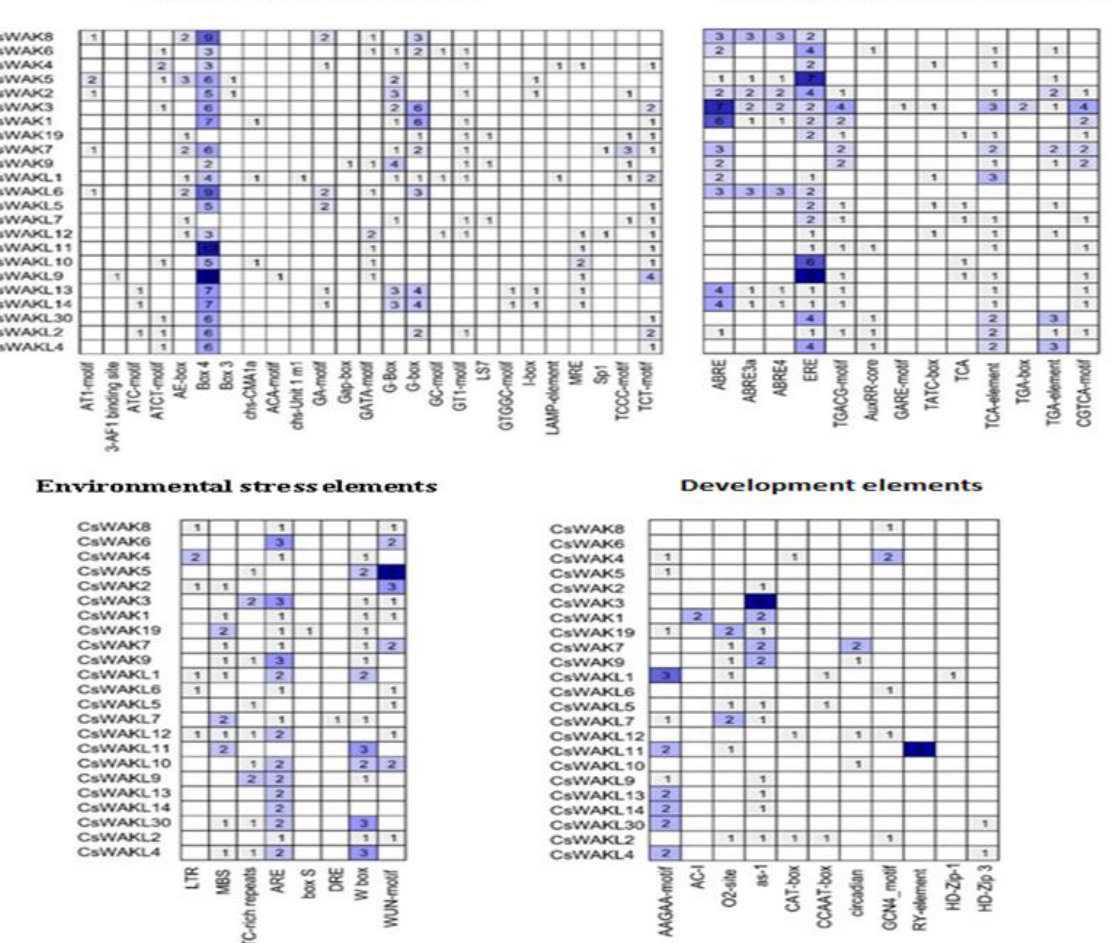
Figure 7. Cis-acting elements in promoter regions of CsWAK s/ CsWAKLs genes. On the basis of func- tions, they were categorized into four major groups: light-responsive elements, hormone-responsive elements, environmental-stress-related elements, and development-related elements. The numbers in the boxes represent the number of cis-acting elements. The background color changes from light blue to dark blue according to the increasing number of cis elements.